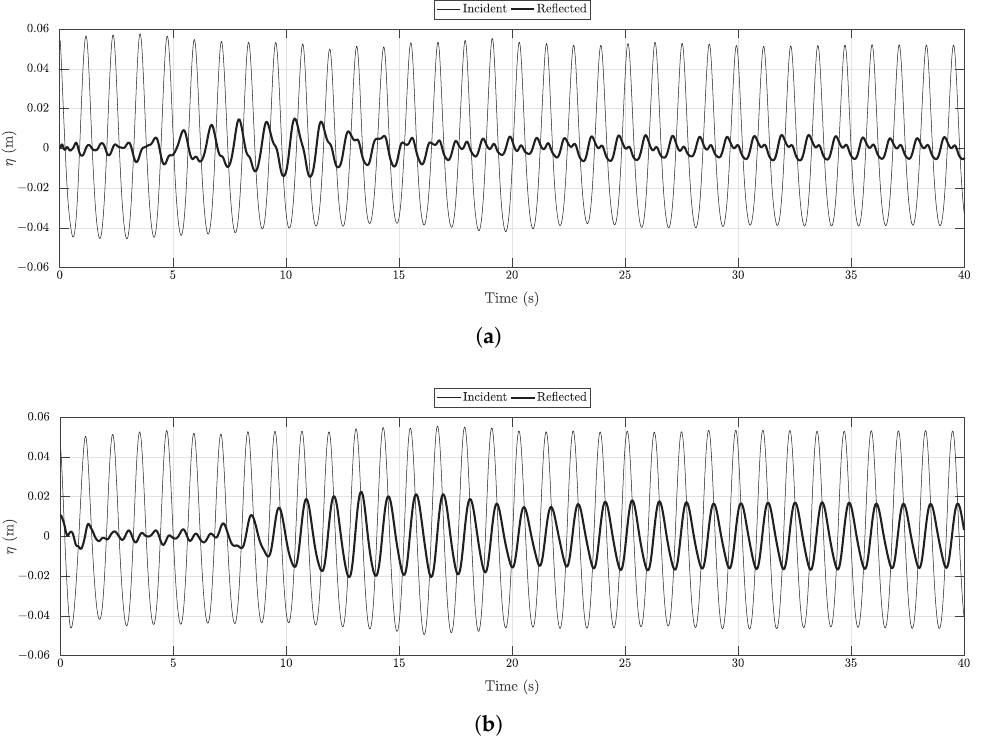
Figure 9. Time-series of incident and reflected waves in front of the cylinder using the combinations DM-AWA and RM-RM for wave generation and absorption. ( a ) Case e, Table 1 ( H = 0.1 m L = 2 m) using DM-AWA; ( b ) Case e, Table 1 ( H = 0.1 m L = 2 m) using